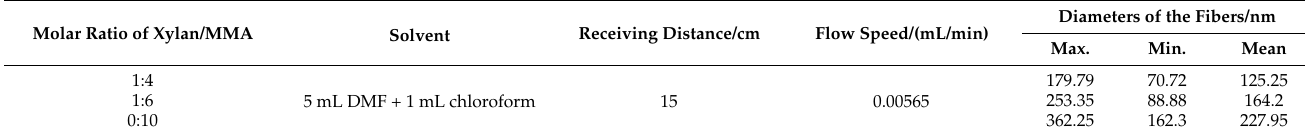
Table 2. The effect of AXU/MMA molar ratios on the diameters of the electrospun fibers.